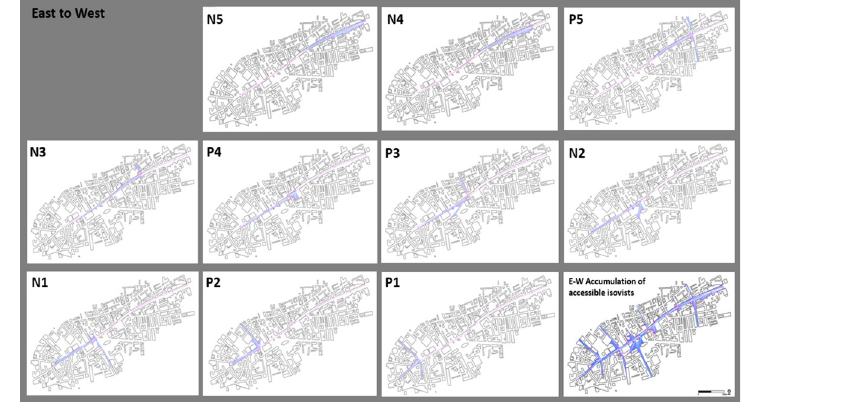
Fig 5. East to West: Accessible isovists by points and their